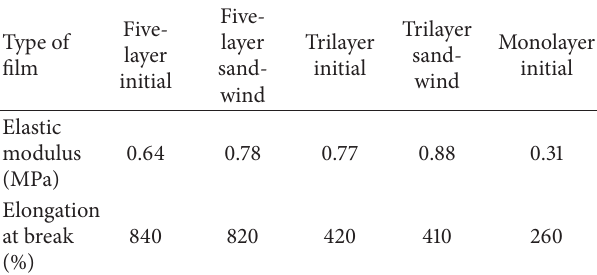
Table 1: Elastic modulus and elongation at break for virgin and aged mono-, tri-, and